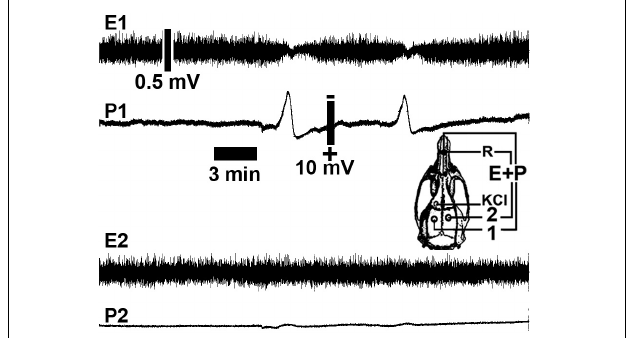
FIGURE 3 | Representative cortical spreading depression (CSD) and electrocorticogram recordings from a rat in a 6-h recording group showing a low number of CSD episodes (two CSD episodes). The spontaneous electrical activity (electrocorticogram; E) and the slow change in potential (P) of CSD were recorded at two points (point 1 in the left hemisphere and point 2 in the right hemisphere) on the rat cortical surface. The skull diagram shows recording points 1 and 2, the point on the ipsilateral hemisphere that was stimulated with KCl to elicit CSD (KCl), and the point over the nasal bones where the common reference electrode (R) was placed. Note that CSD was restricted to the stimulated (left) hemisphere. Calibration bars show the respective